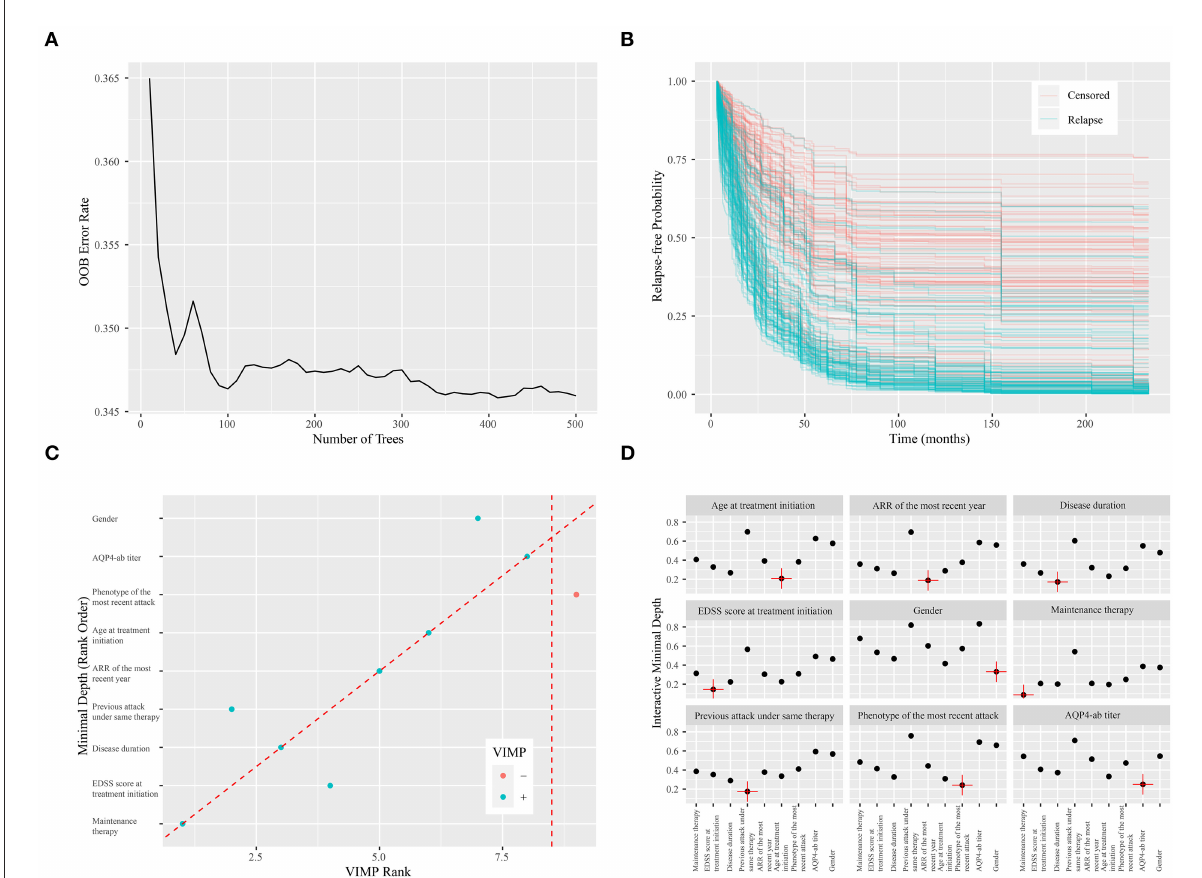
FIGURE3 Random survival forest model. (A) The error rate of model prediction with different numbers of survival trees. (B) Relapse-free estimate for patients in the validation set. The blue line indicates relapse, while the red line indicates censored data. (C) A scatter plot of the variables with minimal depth and variable importance (VIMP) method. The blue dot indicates positive VIMP, while the red dot indicates negative VIMP. (D) Variable interaction plot for nine variables. Higher values demonstrate lower interactivity, with the target variable labeled in